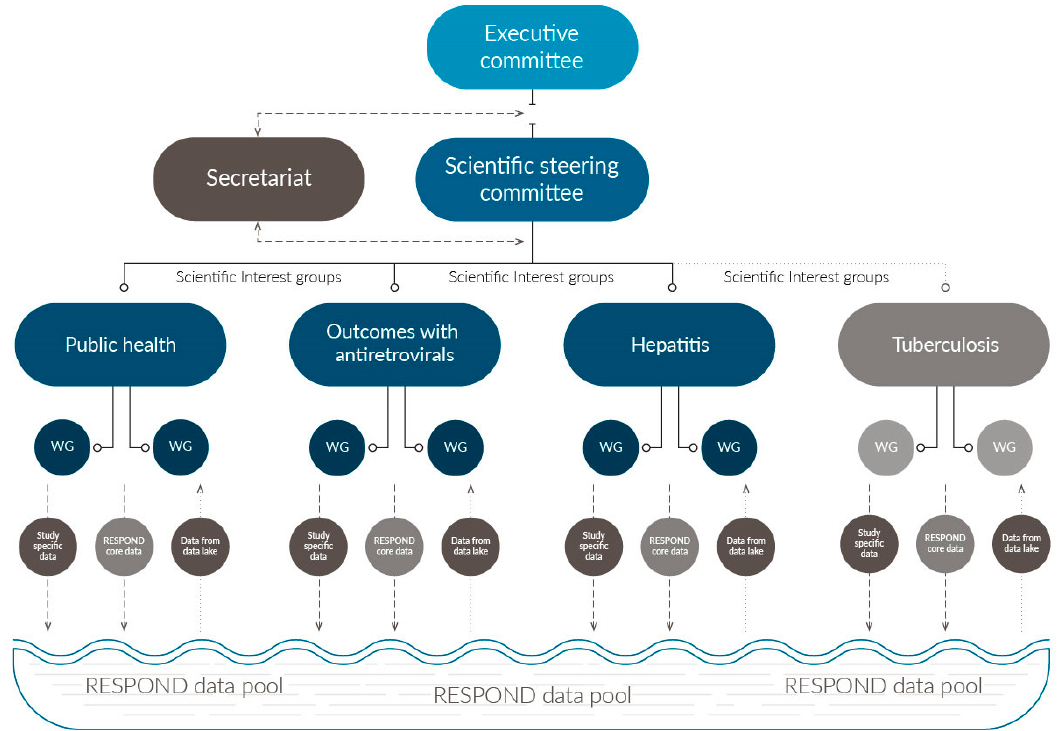
Figure 2. Organization of RESPOND. The executive committee oversee the overall financial wellbeing